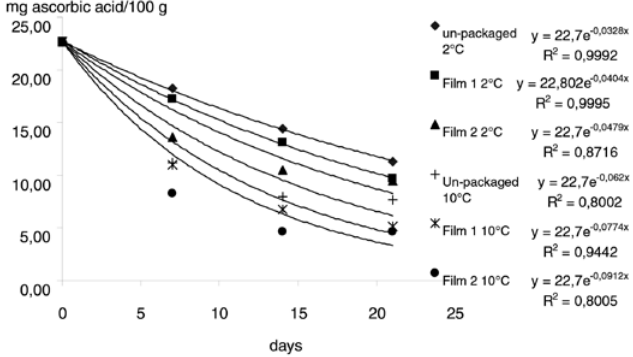
Fig. 5 - Kinetic model of ascorbic acid degradation during